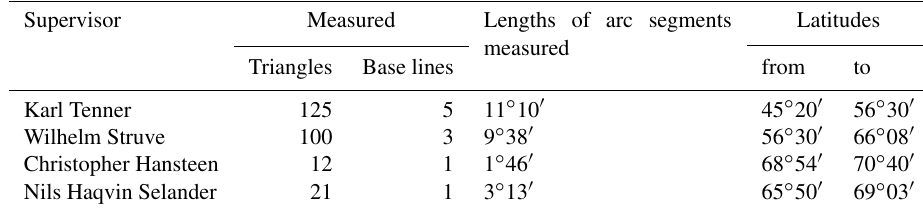
Bielin in the Grodno Governorate. During the measurements, Troughton and Baumann repeating circles were used. Lat- itudes of marginal points were determined, employing the arc is 4 ◦ 32 (cid:48) . Measurements were finished in 1827, and